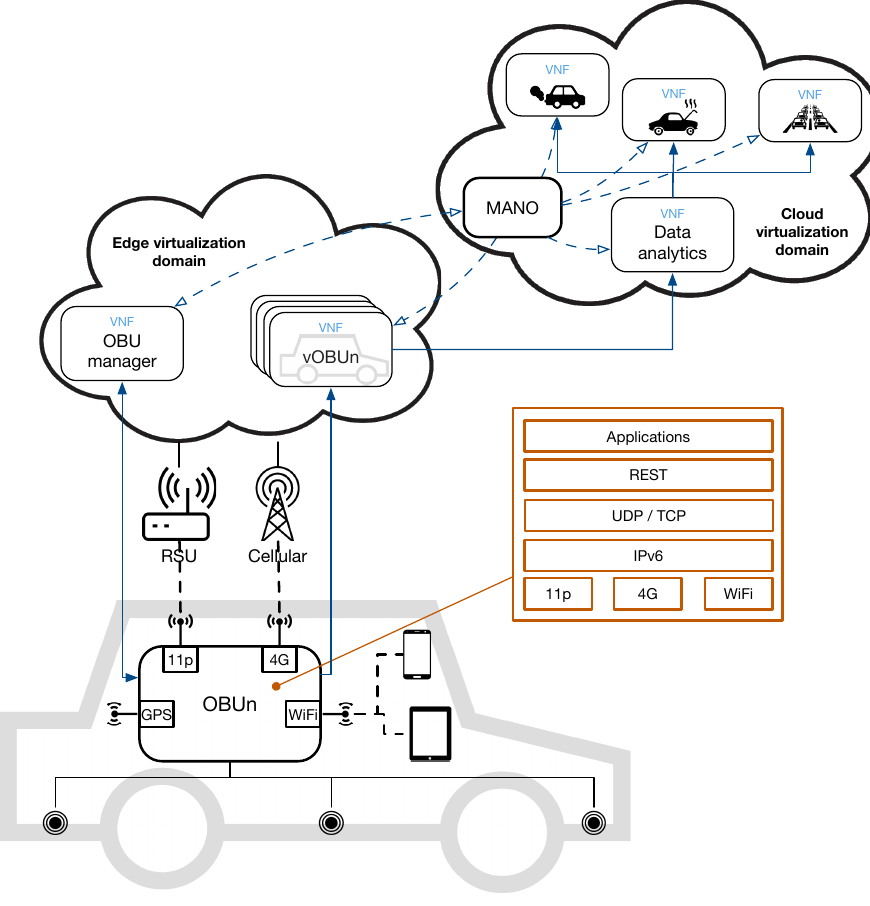
Figure 1. Overall architecture of the virtualization